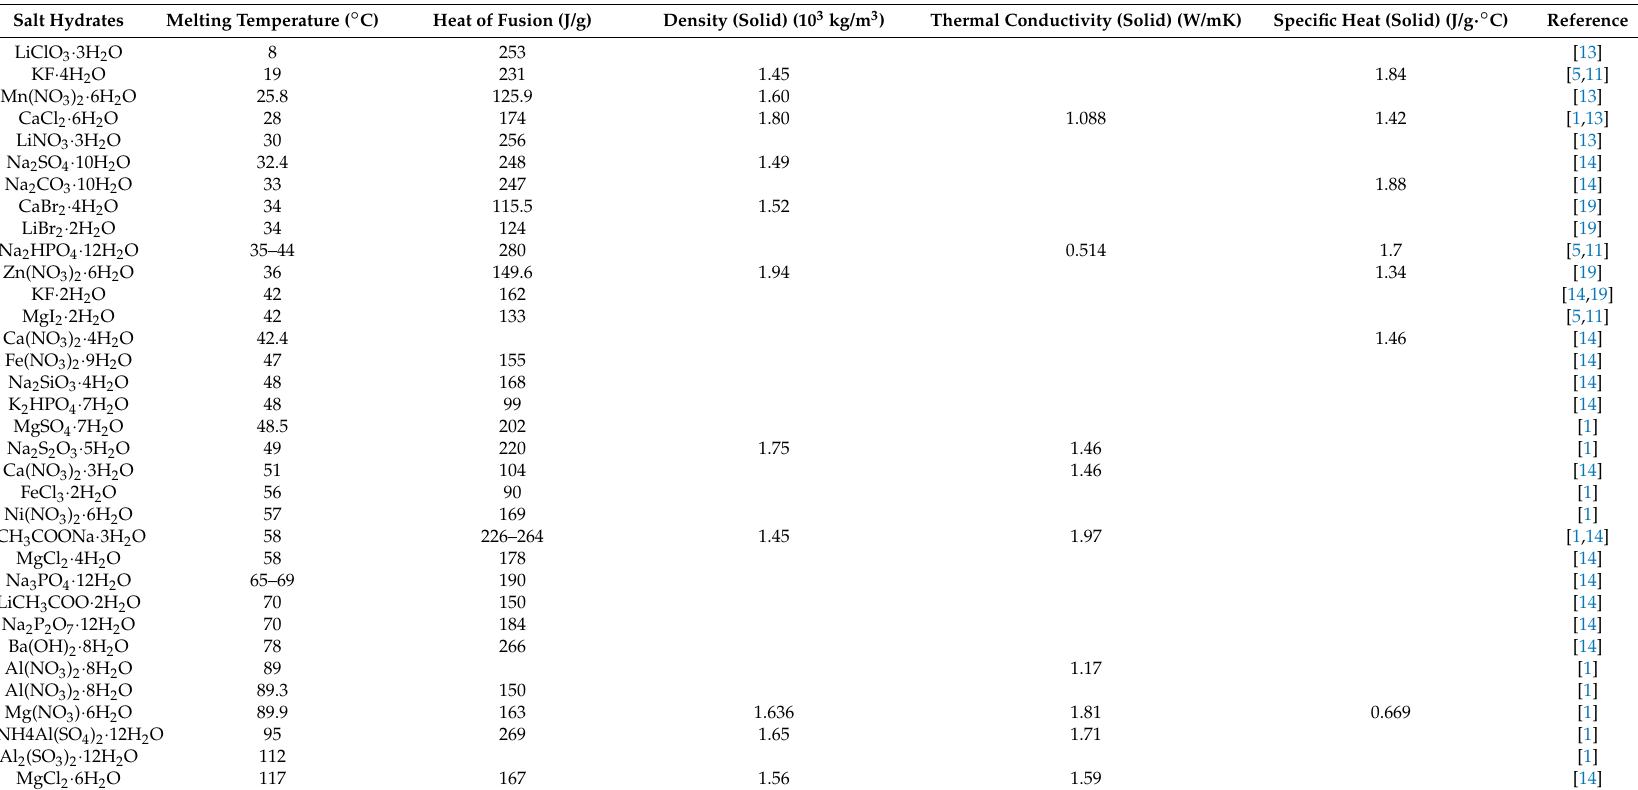
Table 1. Thermo-physical properties of salt